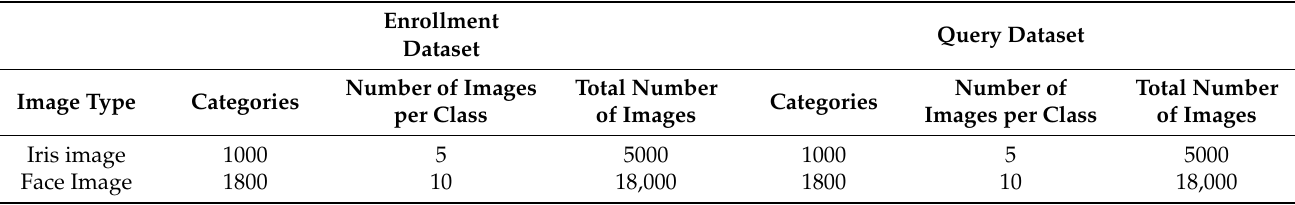
Table 3. Data specifications of separation in the evaluation